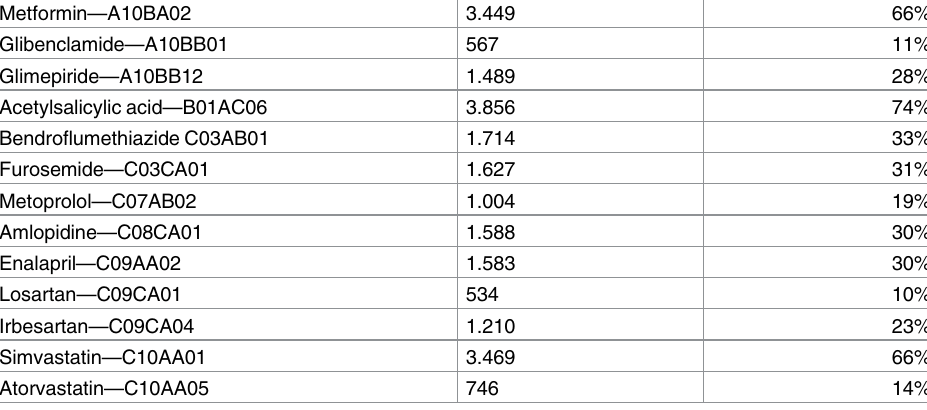
Table 1. Use of 13 most commonly prescribed